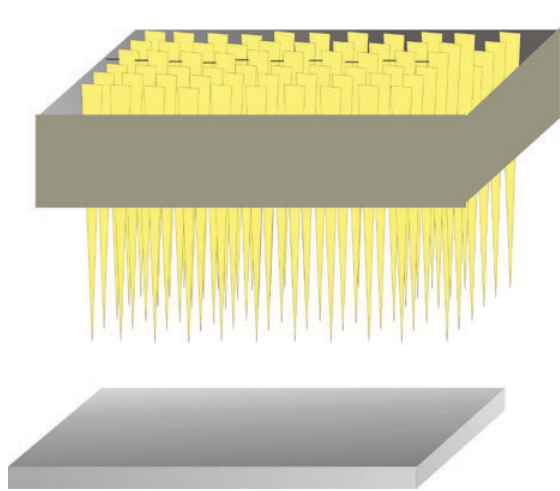
Figure 2. Sample deposition.